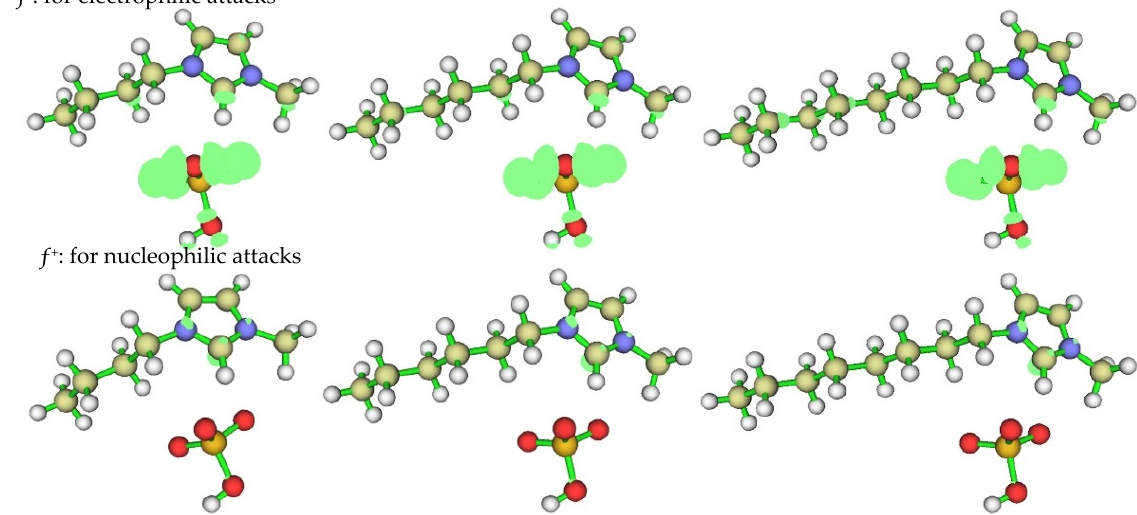
Figure 3. The Fukui function of the nucleophilic attack and electrophilic attack calculated at B3LYP/6-31++G(d,p) for [BMIM]HSO 4 ( left ), [HMIM]HSO 4 ( middle ) and [OMIM]HSO 4 ( right ).